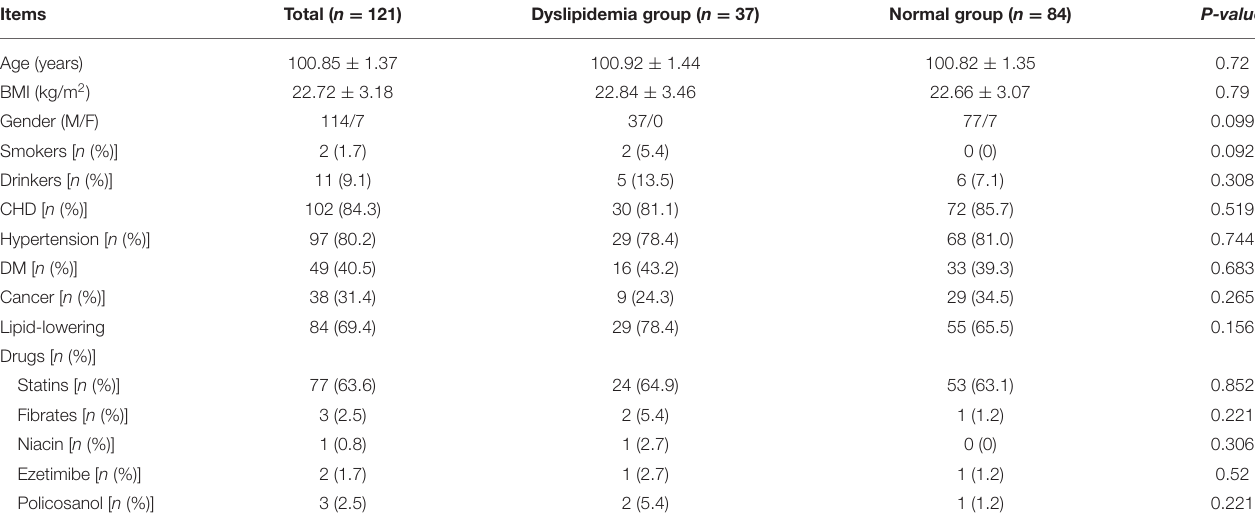
TABLE 1 | The baseline features of inpatient centenarians.